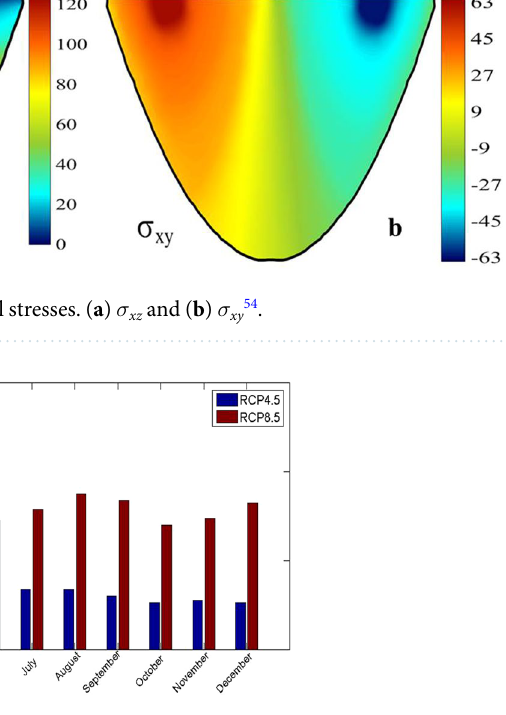
Figure 10. The monthly slope of the temperature under the RCP 4.5 and RCP 8.5